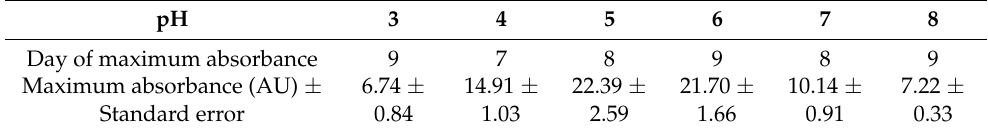
Table 2. Maximum absorbance at 500 nm in shake flasks representing the region for red pigments. pH 3 4 Maximum absorbance (AU) ± Standard